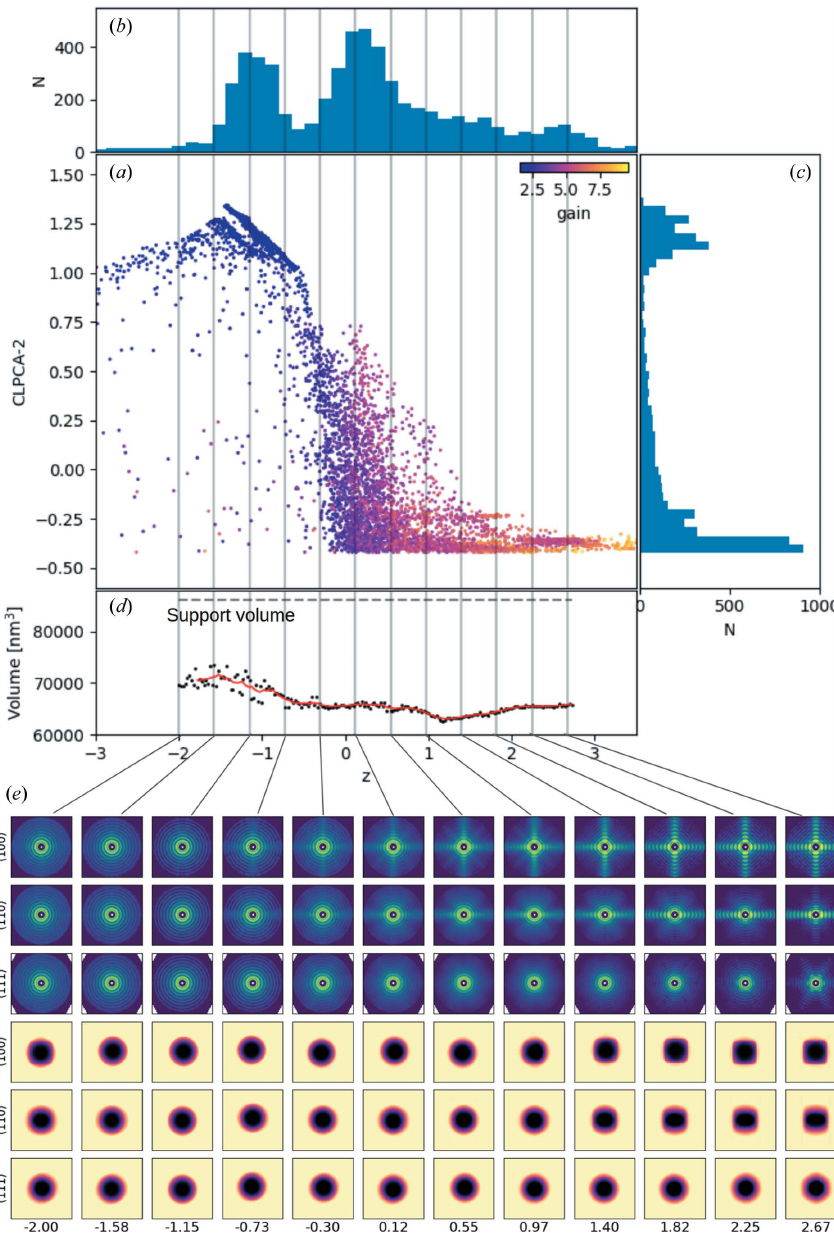
Figure 5 ( a ) VAE-encoded 1D latent number z plotted against CLPCA-2 for the input sample patterns. The colour coding is the gain parameter of each pattern. ( b ) A histogram of latent number z . ( c ) A histogram of CLPCA-2. ( d ) The volume ‘evolution’ along z , with volumes calculated with a density threshold equal to 10 (cid:6) 4 of the total mass. The dashed horizontal line is the size of the support volume in phase retrieval. Vertical grey lines show the locations of the 12 selected z numbers. ( e ) The top three rows are the VAE-generated intensity volumes from the 12 selected z numbers on a logarithmic scale, the three rows showing slices in (from row 1 to row 3) the h 100 i , h 110 i and h 111 i directions, respectively. The bottom three rows show their corresponding density projections in real